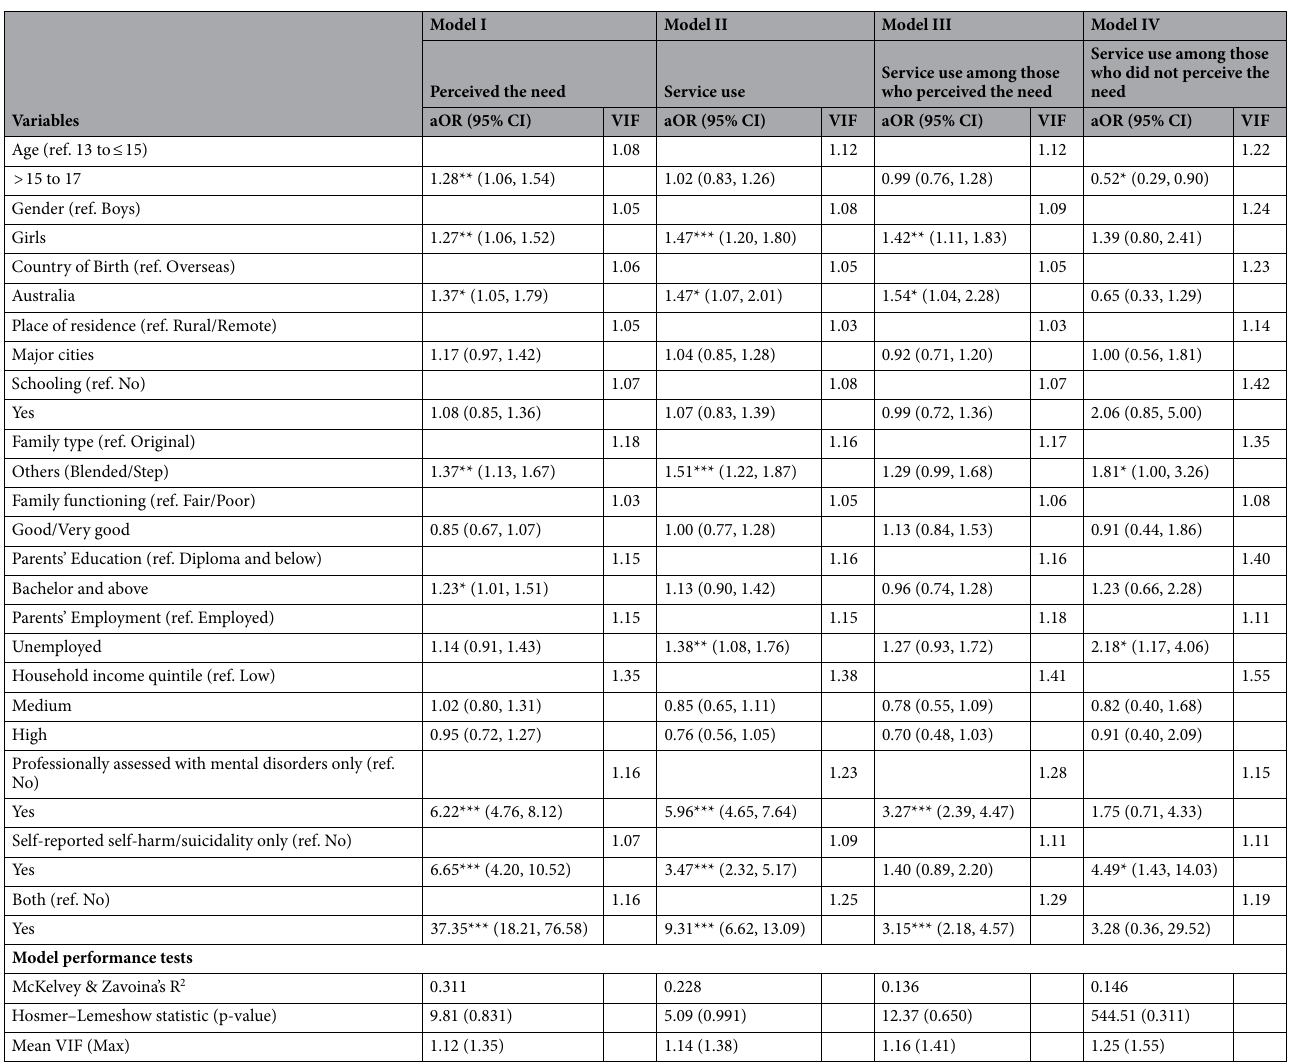
Table 5. Logistic regression models predicting perceived need and service use. Level of significance: *** p < 0.001, ** p < 0.01, * p < 0.05. aOR Adjusted odds ratio, CI Confidence interval; VIF Variance inflation